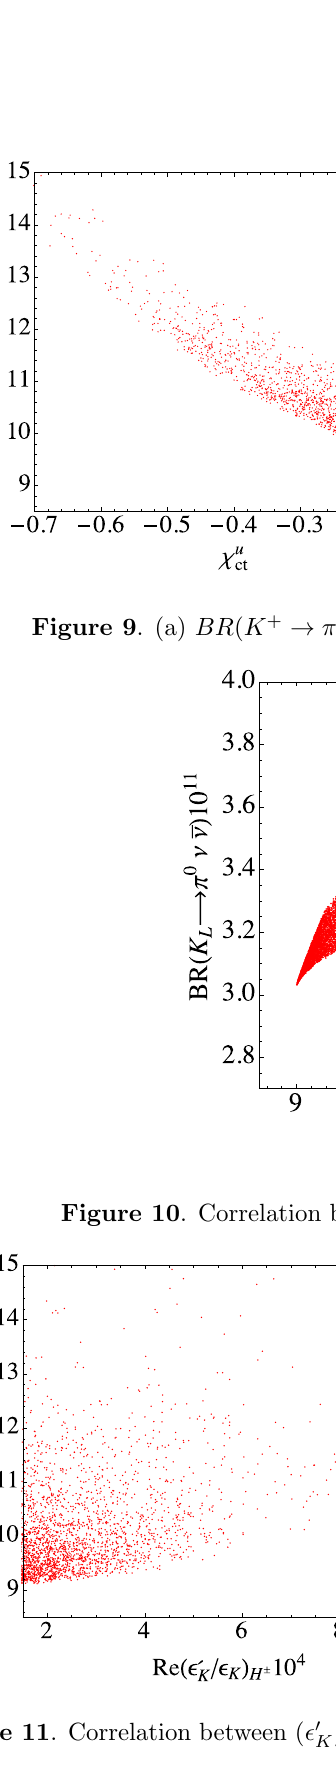
=(cid:15) K ) H (cid:6) and (a) BR ( K + K